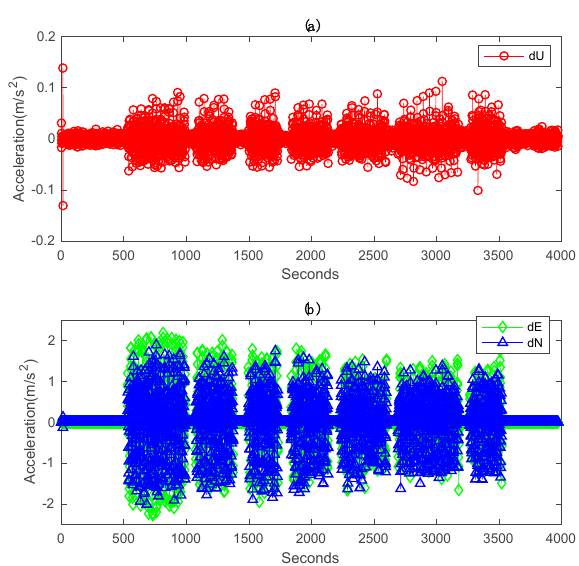
Figure 9. Acceleration time series derived from second-order differencing RTK position time series in Up, East and North: ( a ) acceleration in Up. ( b ) Accelerations in the East and North.